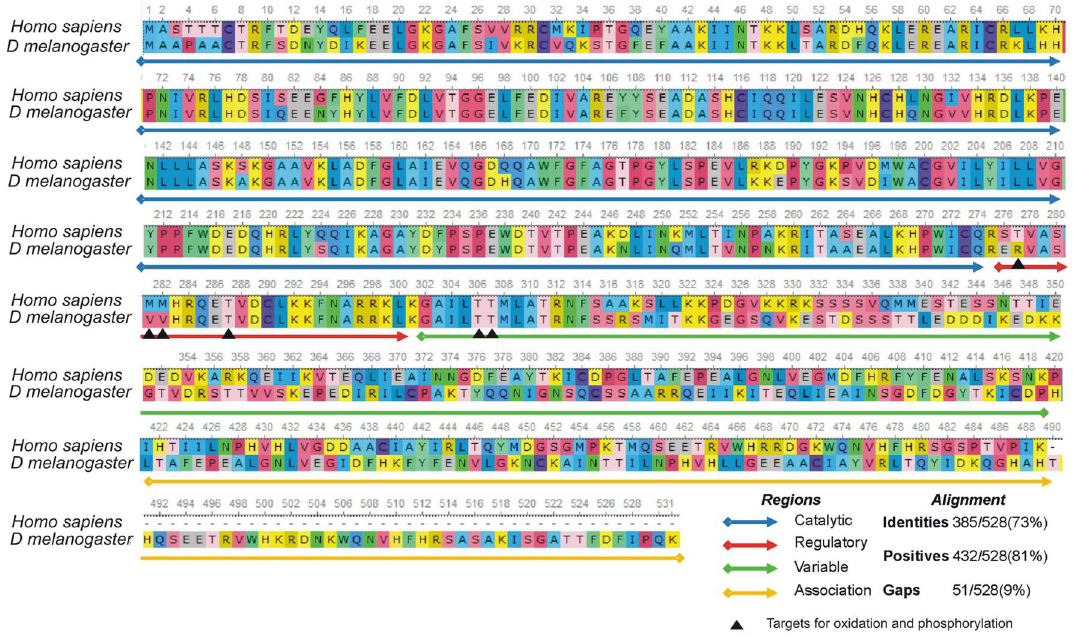
Figure 4. CaMKII from human and Drosophilamelanogaster are highly conserved. Alignment between CaMKII d from Homo sapiens and the corresponding enzyme in Drosophila melanogaster show conserved regions and residues of interest that are targets of phosphorylation. Thr 287 , Thr 306 and Thr 307 on human isoform have their homologous residues in Drosophila melanogaster . This might allow Drosophila melanogaster protein to be regulated by autophosphorylation like occurs in its human homologous enzyme. Unlike phosphorylation sites, Met 281/282 oxidation sites are replaced by valine residues in the fruit fly, thus, regulation by oxidation of Met 281/282 , are absent in Drosophila melanogaster .